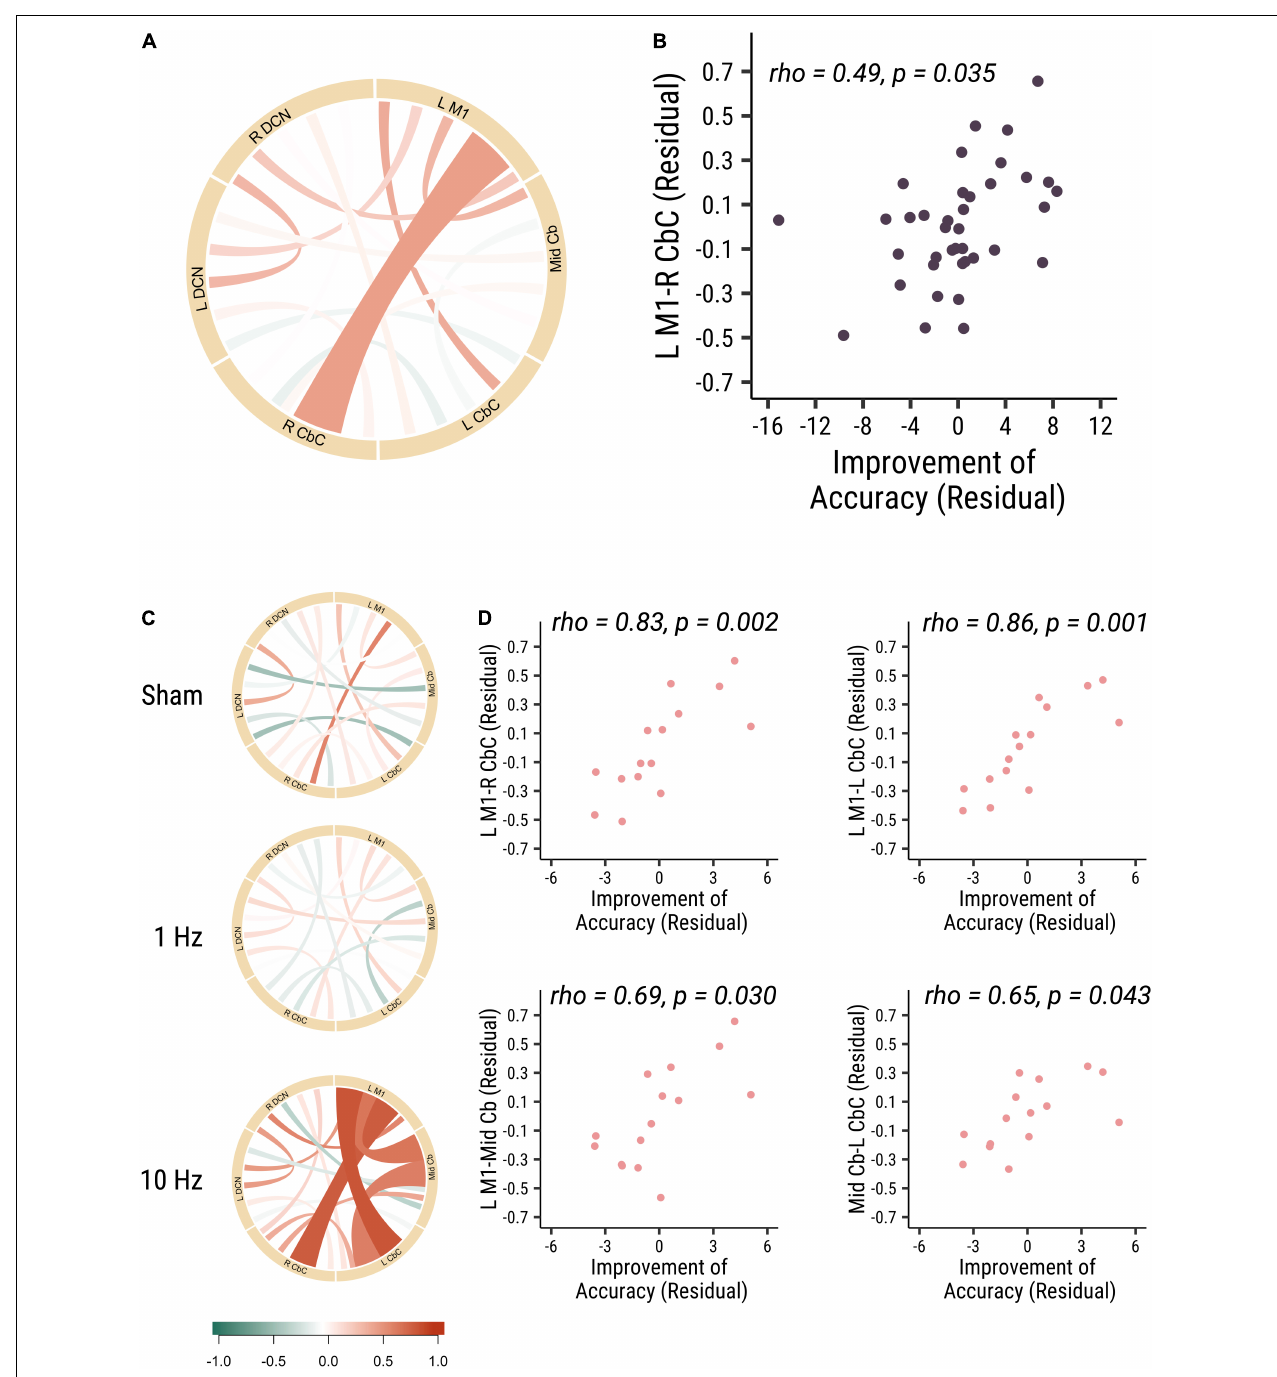
FIGURE 1 | The baseline functional connectivity of M1-cerebellum positively correlated with the improvement in distance from target. (A) The correlation between different functional connectivity and the improvement in accuracy visuomotor performance in all participants. Link colors indicate partial Spearman’s rank correlation coefficient (rho) and link widths indicate the significance of correlation. The color bar shows the correlation coefficient scale. A thicker link shows a significant relationship (p-value < 0.05) between the functional connectivity of two ROIs and the accuracy improvements, and a thinner line shows no significant association between the functional connectivity and behavior. (B) The correlation between M1-R CbC functional connectivity and the accuracy improvements (rho = 0.49, p = 0.035). (C) The correlation between different functional connectivity and the accuracy improvements among three different cerebellar rTMS groups. (D) The correlation between functional connectivity between L M1-R CbC (rho = 0.83, p = 0.002; top right panel), L M1-L CbC (rho = 0.86, p = 0.001; top left panel), L M1-Mid Cb (rho = 0.69, p = 0.03; bottom right panel) and Mid Cb-L CbC (rho = 0.65, p = 0.043; bottom left panel) functional connectivity and the accuracy improvements in the 10 Hz rTMS group. Each point is one participant. Each point is one participant. (L M1 = left motor cortex; R CbC = right cerebellar cortex; L CbC = left cerebellar cortex; R DCN = right deep cerebellar nucleus; L DCN = left deep cerebellar nucleus; Mid Cb = midline